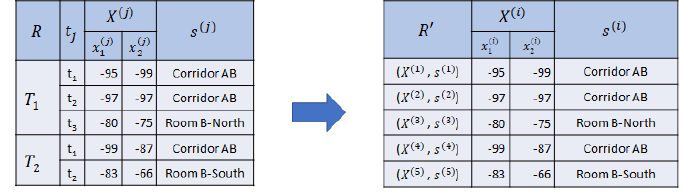
Figure 3. Transforming R (left) to R (cid:48) ( right